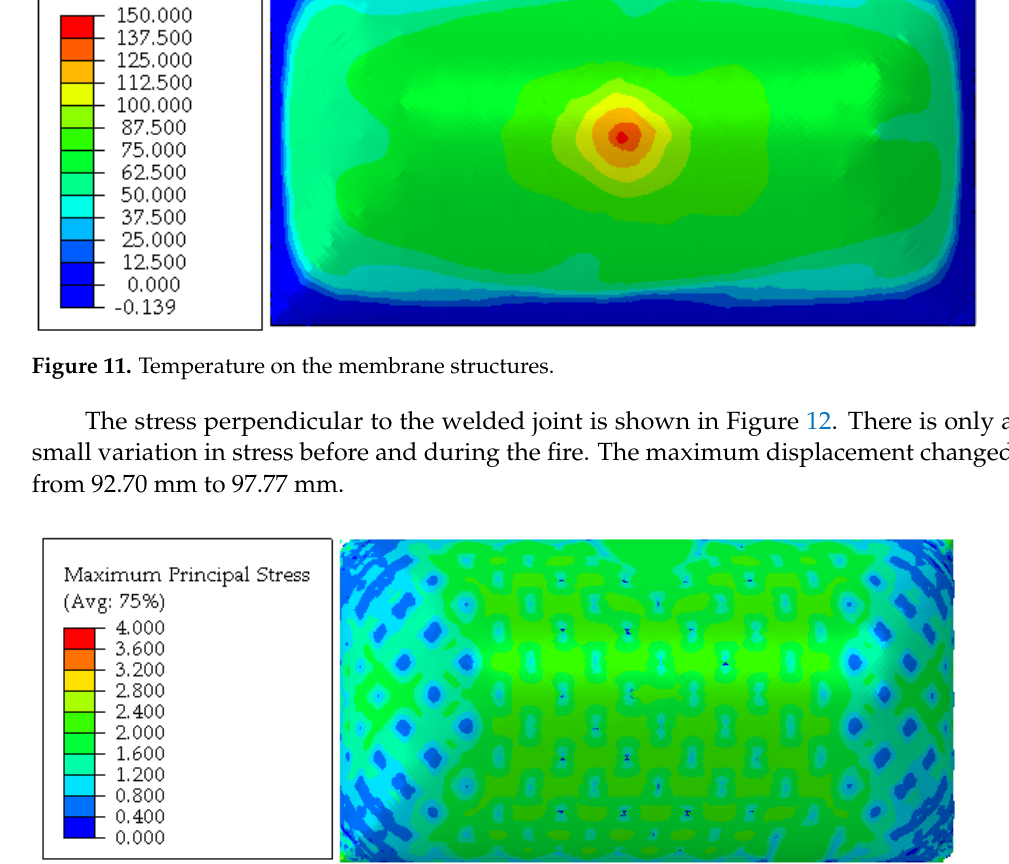
Figure 10. Stress of the model under pressure difference and gravity (MPa).